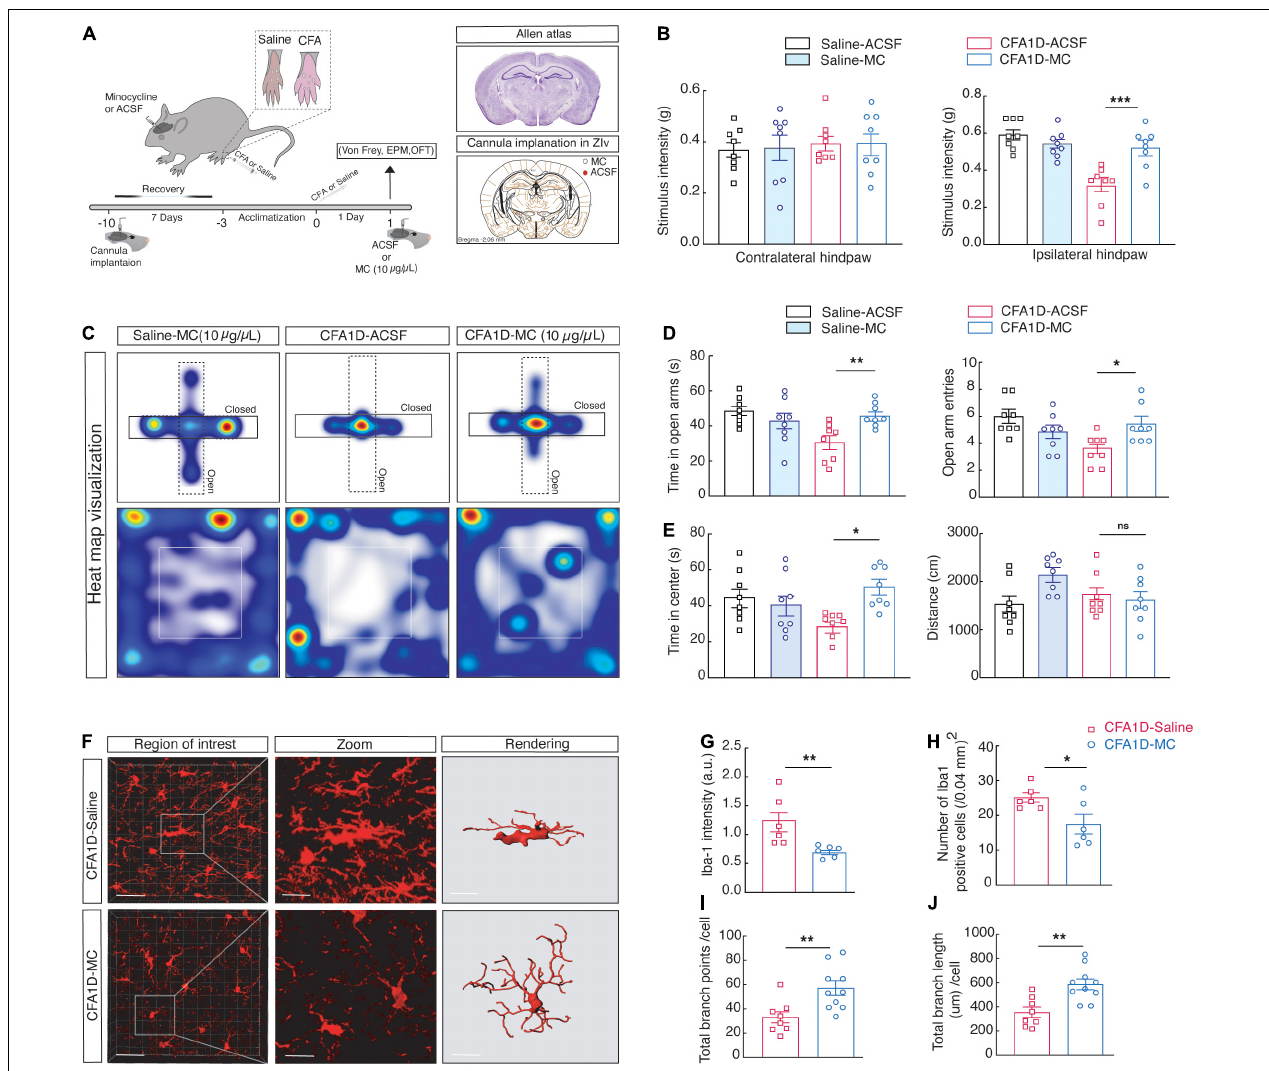
FIGURE 5 | Inactivating microglial cells in ZI V of CFA1D mice reverses anxiety-like behavior in pain and the dynamic modifications of microglial status. (A) Schematic diagram of the experiment and cannula implantation in ZI V . (B) Stimulus intensity of the ipsilateral ( P = 0.002) and contralateral ( P > 0.9) hind paws CFA1D mice during intra- ZI V injection of minocycline (10 µ g/ µ L) or ACSF, Ordinary one-way ANOVA with Bonferroni’s multiple comparisons tests. (C–E) Heat map visualization and statistics data from EPM [Time in open arm ( P = 0.0024), open-arm entries] and OFT [Time in the center ( P = 0.0114) and distance traveled] apparatuses in CFA1D mice during intra- ZI V injection of minocycline (10 µ g/ µ L) or ACSF, n = 8 mice per group. (F) Fluorescence images of Iba-1 + cells from CFA1D mice with saline or minocycline, scale bar, 20 µ m. Sections show a detailed view of the white box; scale bar, 10 µ m. (G–J) Statistical data for the Iba-1 + cell’s number, Iba-1 intensity, endpoints, and process lengths per cell. n = 6 slices per group from three mice. (G,H) Statistical data for the number of Iba-1 + cells per cubic millimeter (Iba-1 + cells; t 10 = 2.448 and P = 0.0344) and Iba-1 intensity (Iba-1 intensity; t 10 = 3.29 and P = 0.0081) in the ZI V from saline- and minocycline treated CFA1D mice. (I,J) Summary data of microglia total branches endpoints ( t 16 = 3.054 and P = 0.0076) and all process lengths per cell of Iba-1 + microglia ( t 16 = 3.65 and P = 0.0022) in ZI V from saline- and minocycline treated CFA1D. All data are expressed as mean ± SEM. n = 6–11 slices per group from three mice. * P < 0.05, ** P < 0.01, *** P < 0.001; ns, not